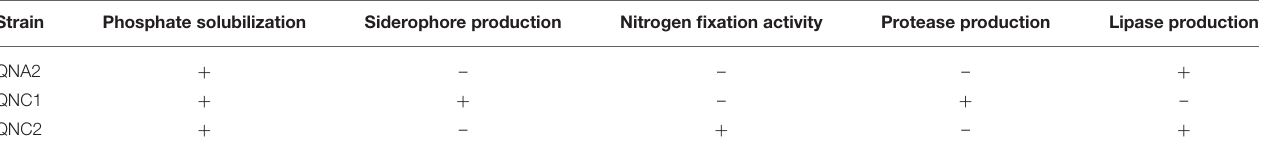
TABLE 2 | Plant growth potential properties of endophytic bacterial strains isolated from alfalfa and chickpea plants. Strain